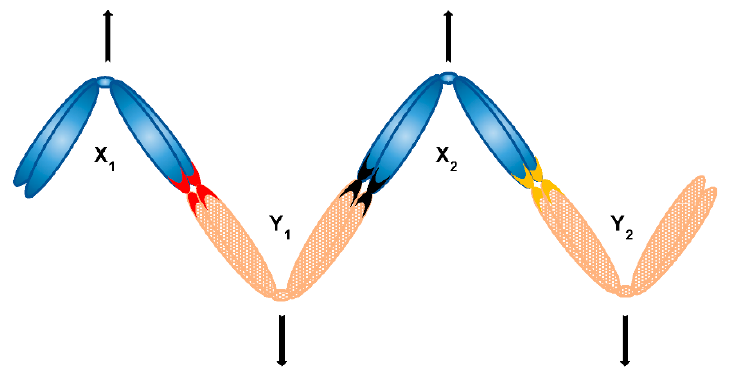
Figure 7. Alternate segregation of a chain sex chromosome multiple consisting of four sex chromo- somes (X 1 X 2 Y 1 Y 2 system) can be achieved with formation of a zig-zag structure; respective contacts of sex chromosomes (e.g., PARs) are depicted as coloured chromosome tips.